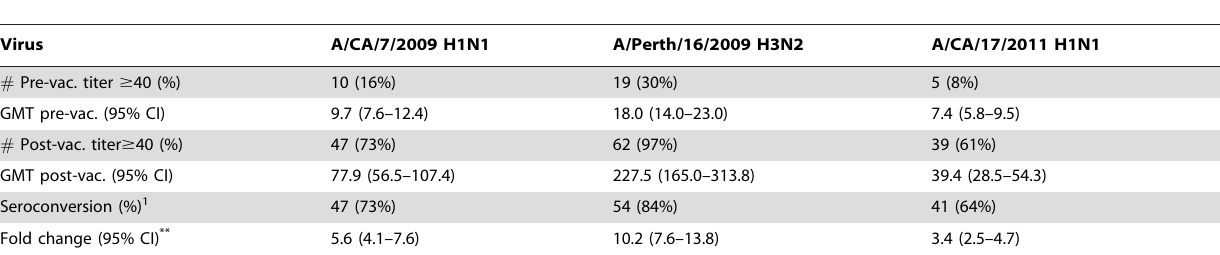
Table 2. Serologic responses in vaccinated recruits as measured by microneutralization assay, TIV-vaccinated recruits (n=64).